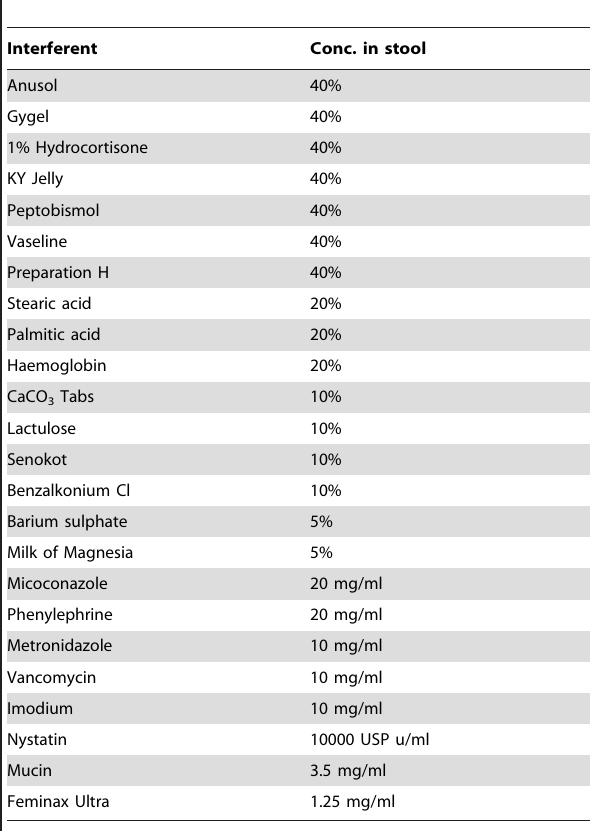
Table 3. Concentrations of substances that do not interfere with the detection of C. difficile by HE-LAMP-BART.